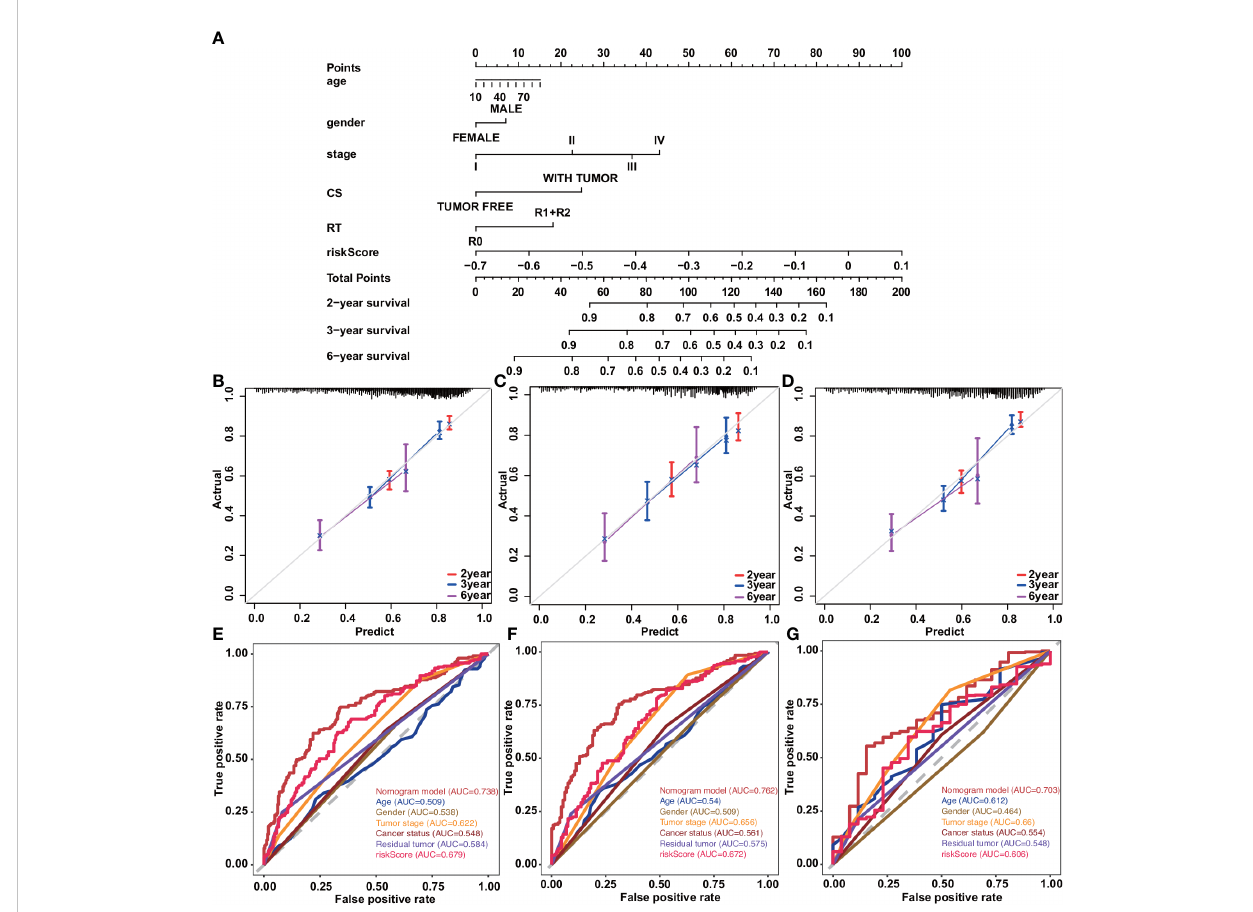
FIGURE 6 Construction and validation of a nomogram in patients with digestive system tumors. (A) Nomograms used to predict 2-, 3-, and 6-year overall survival for patients in the training cohort. (B – D) Calibration curves of nomograms in terms of agreement between predicted and observed 2-, 3-, and 6-y outcomes in the training (B) , validation (C) , and entire (D) cohorts. Dashed line at 45°represents perfect prediction, and the actual performance of our nomogram is the red, blue, and pink lines. (E) ROC curve for predicting 2-year OS by risk score. (F) ROC curve for predicting 3- year OS by risk score. (G) ROC curve for predicting 6-year OS by risk